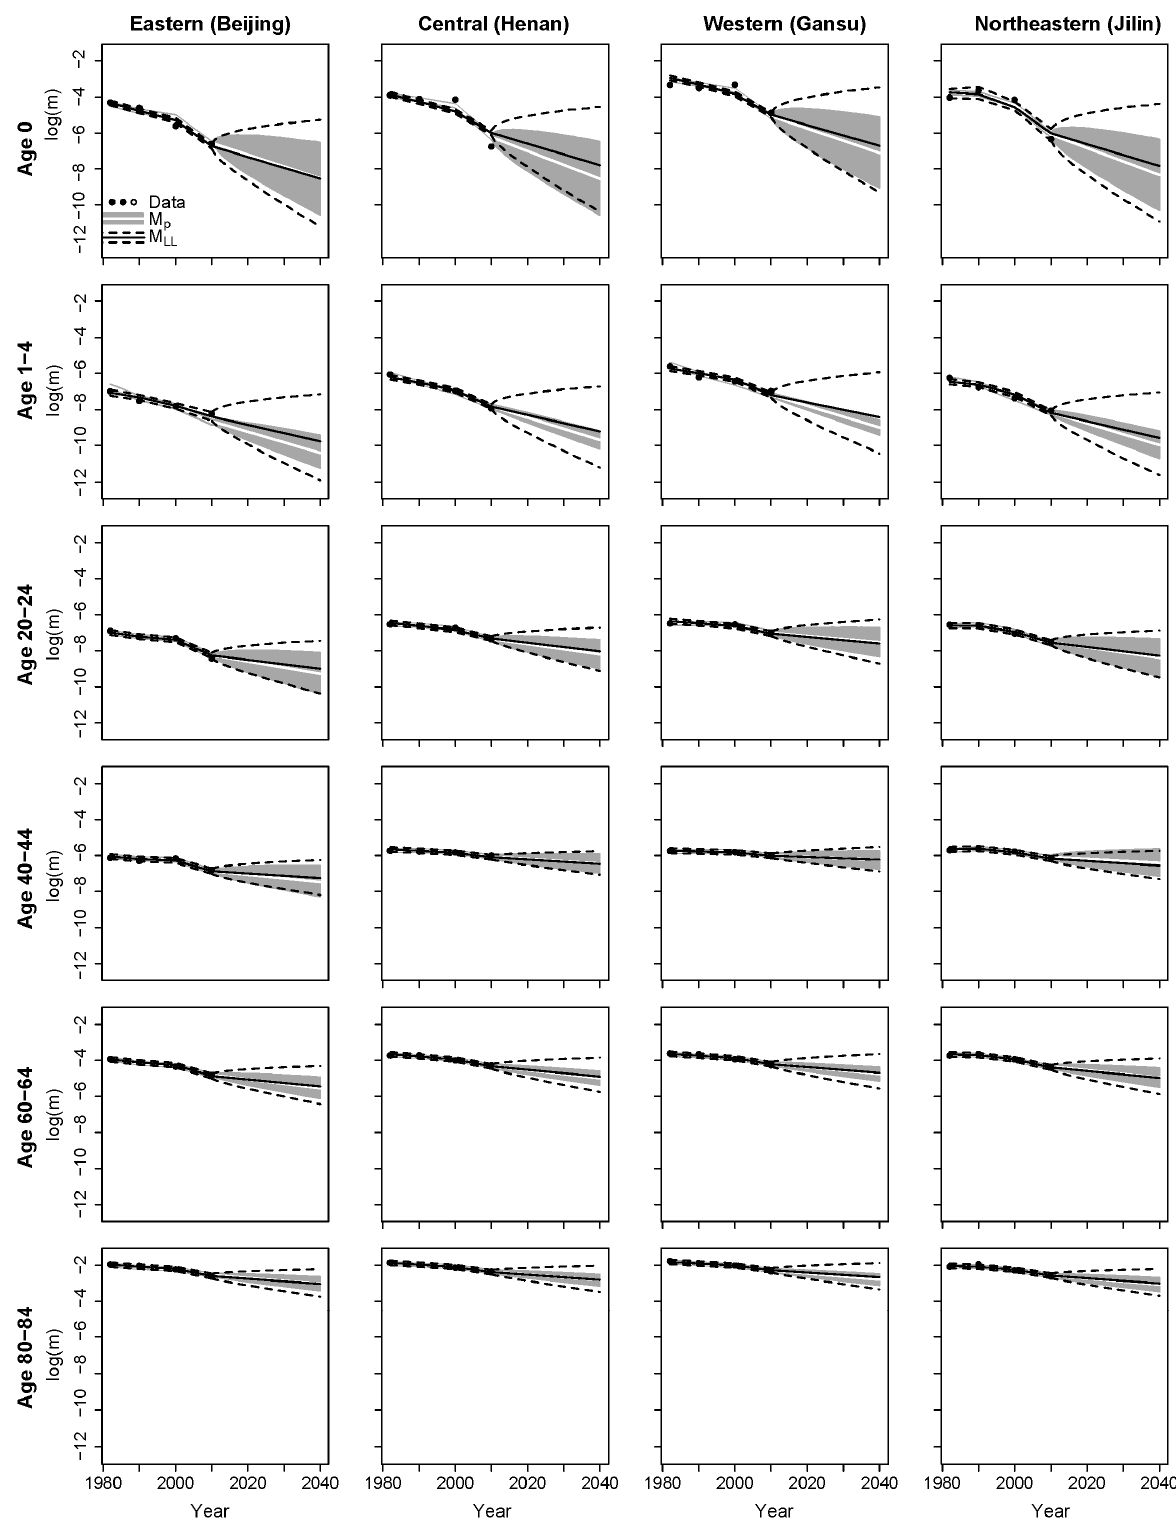
Figure 6. Estimates and forecasts of the proposed model M p and the Li–Lee model M LL.